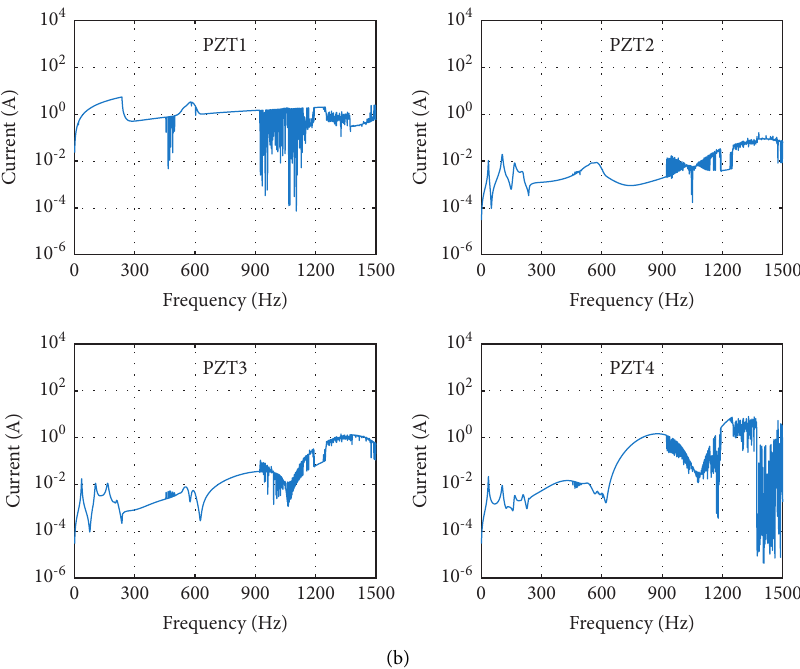
Figure 12: Voltages and currents for the minimum force transmissibility of PSPS. (a) Driving voltages of the four piezoelectric stacks. (b) Driving currents of the four piezoelectric stacks.